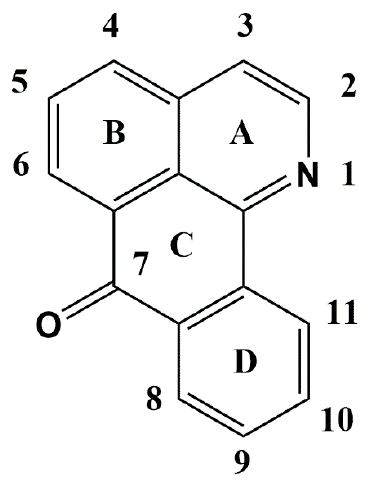
Figure 1. Molecular structure of 1-azabenzanthrone.